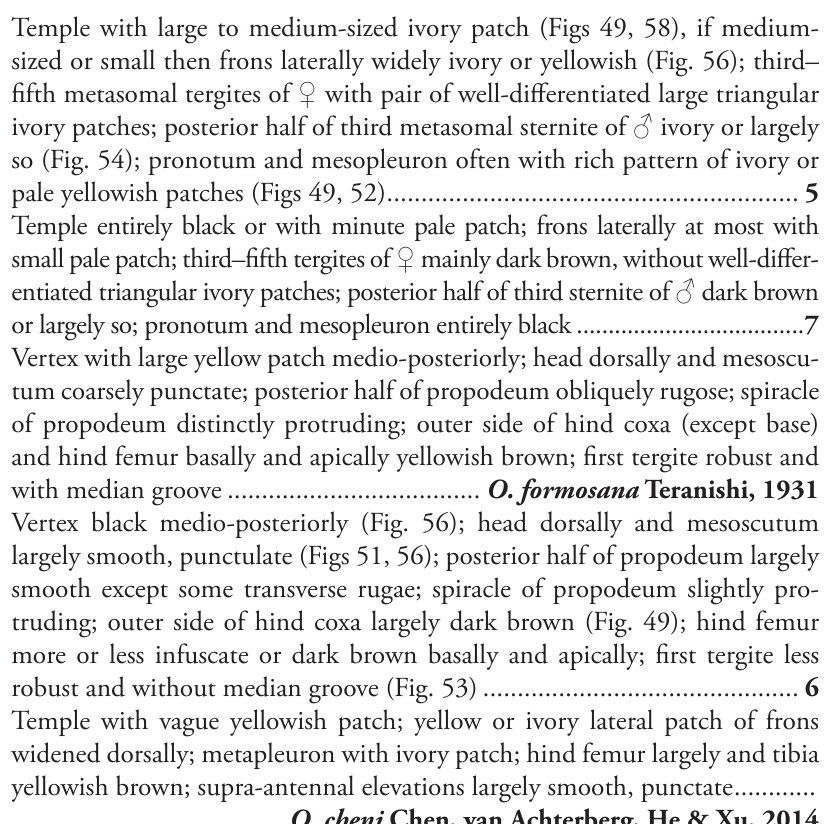
Temple with large to medium-sized ivory patch (Figs 49, 58), if medium- sized or small then frons laterally widely ivory or yellowish (Fig. 56); third– fifth metasomal tergites of ♀ with pair of well-differentiated large triangular ivory patches; posterior half of third metasomal sternite of ♂ ivory or largely so (Fig. 54); pronotum and mesopleuron often with rich pattern of ivory or pale yellowish patches (Figs 49, 52) ............................................................ 5 – Temple entirely black or with minute pale patch; frons laterally at most with small pale patch; third–fifth tergites of ♀ mainly dark brown, without well-differ- entiated triangular ivory patches; posterior half of third sternite of ♂ dark brown or largely so; pronotum and mesopleuron entirely black .................................... 7 5 Vertex with large yellow patch medio-posteriorly; head dorsally and mesoscu- tum coarsely punctate; posterior half of propodeum obliquely rugose; spiracle of propodeum distinctly protruding; outer side of hind coxa (except base) and hind femur basally and apically yellowish brown; first tergite robust and with median groove ..................................... O. formosana Teranishi, 1931 – Vertex black medio-posteriorly (Fig. 56); head dorsally and mesoscutum largely smooth, punctulate (Figs 51, 56); posterior half of propodeum largely smooth except some transverse rugae; spiracle of propodeum slightly pro- truding; outer side of hind coxa largely dark brown (Fig. 49); hind femur more or less infuscate or dark brown basally and apically; first tergite less robust and without median groove (Fig. 53) .............................................. 6 6 Temple with vague yellowish patch; yellow or ivory lateral patch of frons widened dorsally; metapleuron with ivory patch; hind femur largely and tibia yellowish brown; supra-antennal elevations largely smooth, punctate ............ ........................................ O. cheni Chen, van Achterberg, He & Xu, 2014 – Temple with well-differentiated yellowish patch (Figs 49, 58); yellow lateral patch of frons parallel-sided or narrowed dorsally (Fig. 56); metapleuron usu- ally entirely black (Figs 49, 52); hind femur (except sometimes medially) and tibia largely dark brown (Figs 49, 59); supra-antennal elevations with coarse rugae (Fig. 56) ............................. O. hirasana Teranishi, 1929, re-instated 7 Length of eye 0.9–1.1 times temple in dorsal view; mesoscutum densely (ru- gulose-)punctate, hardly shiny and robust in dorsal view; temple often en- tirely black; basally second sternite of ♀ ivory; posterior half of propodeum with some transverse rugae; fifth and sixth metasomal tergites more or less ivory medio-apically; slightly more robust species ( ♀ ); medially third sternite 0.4–0.7 times as long as second sternite (Fig. 73) .......................................... – Length of eye 1.2–1.3 times temple in dorsal view; mesoscutum sparsely punctulate, distinctly shiny and rather slender in dorsal view; temple usually with small pale patch; basally second sternite of ♀ dark brown; posterior half of propodeum often largely smooth; slender species ( ♀♂ ); medially third sternite 0.6–1.0 times as long as second sternite, rarely less; [first tergite with pair of pale spots ( ♀ ) or black ( ♂ ); apical half of mandible reddish-brown